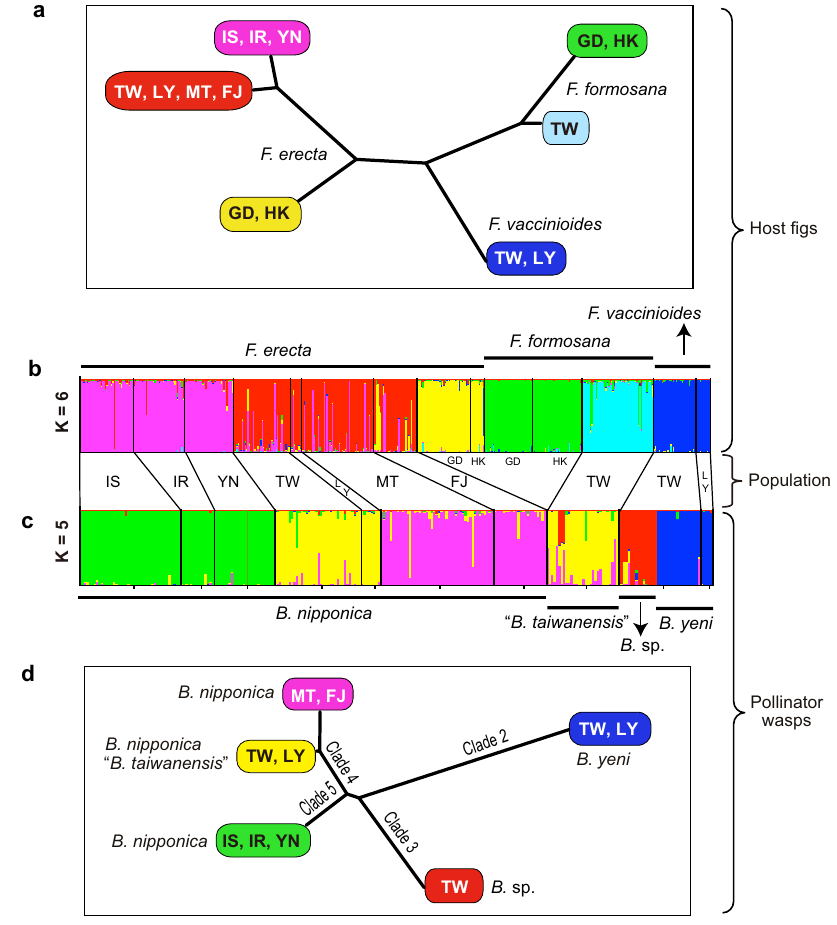
Fig. 4 Population genetic structures (b and c) and trees (a and d) of the clusters based on SSR data. SSR data were genotyped from nine loci for fi gs and from 15 loci for pollinator wasps. K = 6 and K = 5 were the most likely K for fi gs and wasps, respectively (structures with K = 5 and K = 7 are also shown for fi gs in Supplementary Fig. 11). The trees were computed by applying the NJ algorithm to the matrix of allele-frequency divergence among clusters 69,70 . The samples used in these analyses are shown in Table 1 and Supplementary Data 1. For the abbreviation of population names, refer to Fig. 1. The clades shown in ( d ) correspond to those in Fig.